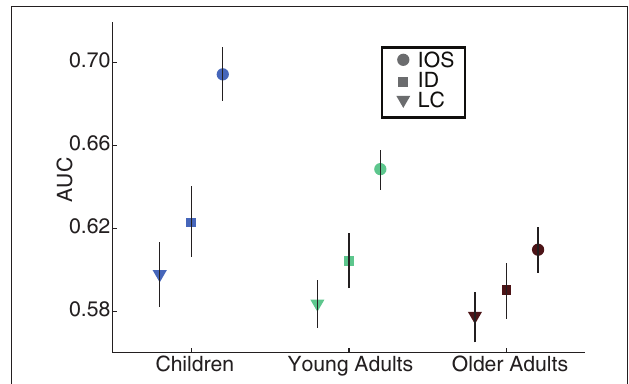
Figure 6 | One average feature (LC) and the best feature (iD) compared to inter-observer (iO) saliency. For each age group separately, image-specific AUC (AUC ) values were pooled from the fractals and manmades categories. I Markers show for two features and the IO saliency the medians of those distributions together with the 95% CIs. Even though there was considerable overlap in these conservative CIs, all AUCs drop with age, replicating the category-pooled analysis.